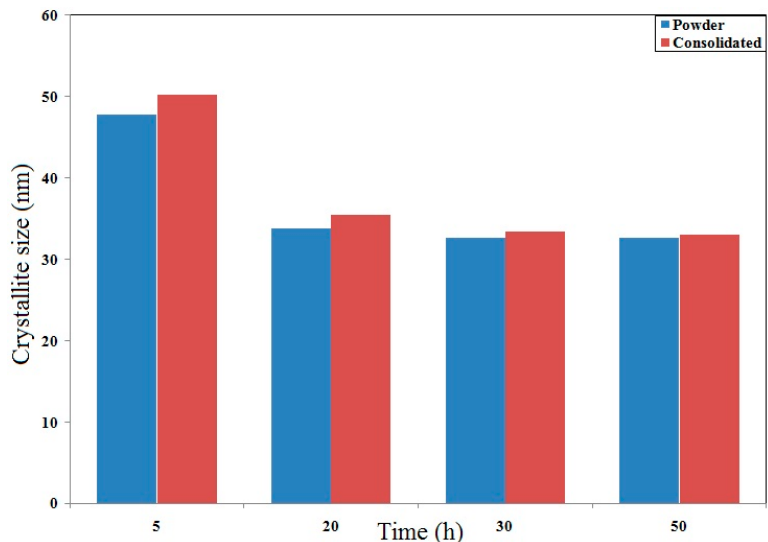
Figure 3. Crystallite size (nm) as a function of milling time (h) for powder and consolidated samples determined by the W-H method.